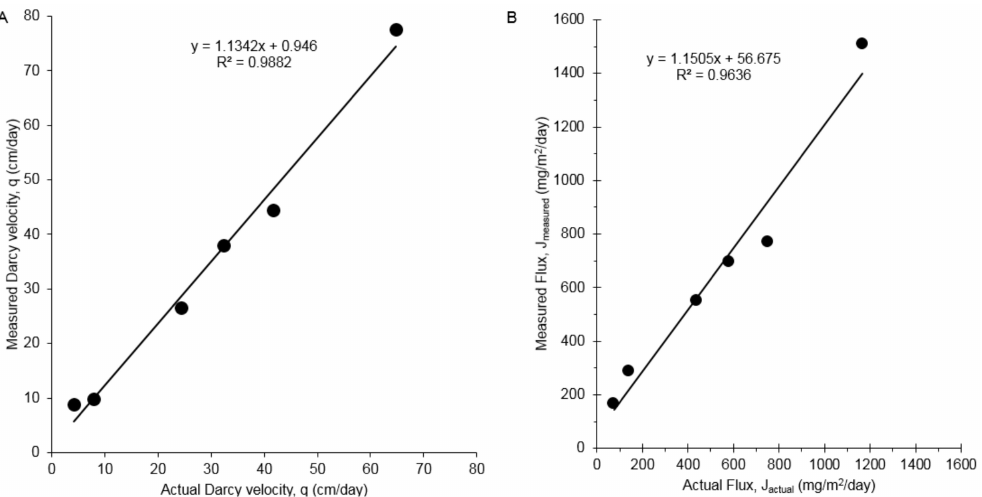
Figure 4. ( A ) Actual versus measured Darcy velocity with a standard PFM; ( B ) Actual vs measured 1,4-dioxane flux in box aquifer tests on the standard PFM.